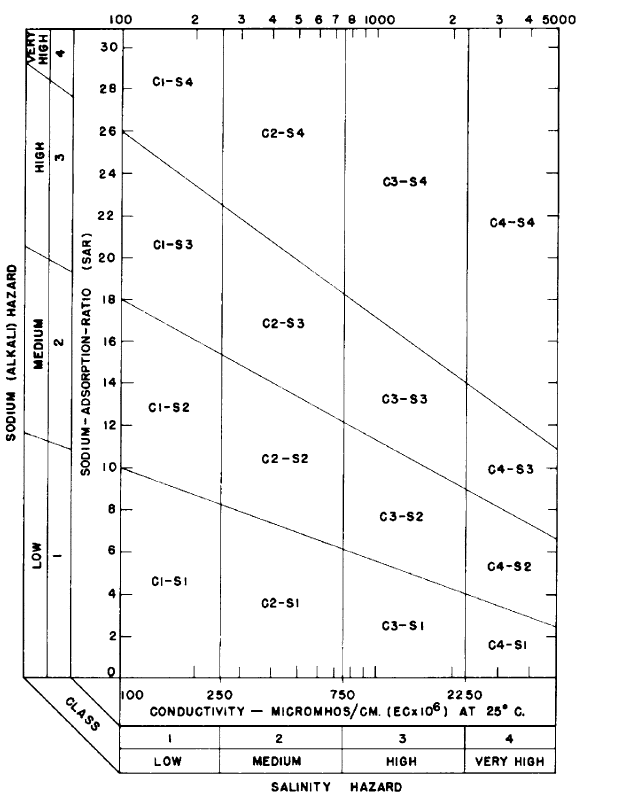
Fig. 3 Diagram for the classification of irrigation waters (Richards